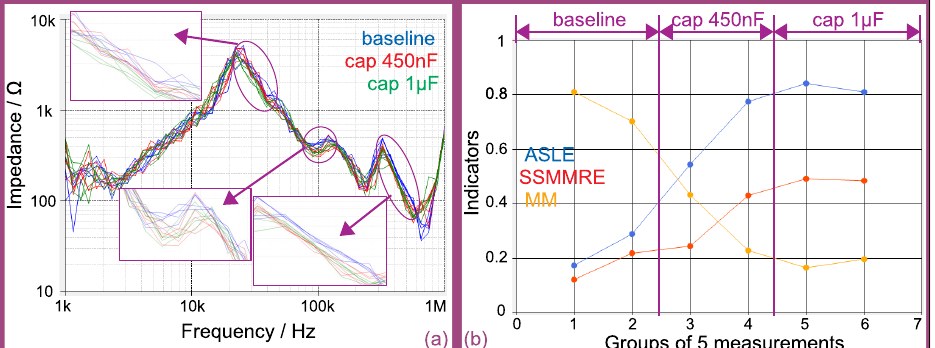
Figure 16. Online FRA for a progression of turn insulation failure (capacitors inserted between taps): ( a ) impedance spectra; ( b ) trend curves of some statistical